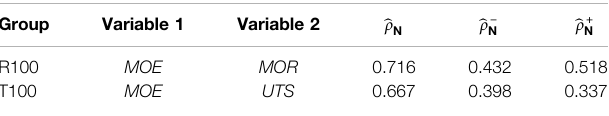
TABLE 3 | The correlation and semi-correlations of the normal scores for R100 and T100. (cid:4) ρ N denotes the correlation of normal scores. The semi-correlations (cid:4) ρ + (cid:4) ρ − N and N denote the correlations in the lower quadrant and upper quadrant, respectively, in the right-hand side of Figures 1 and 2